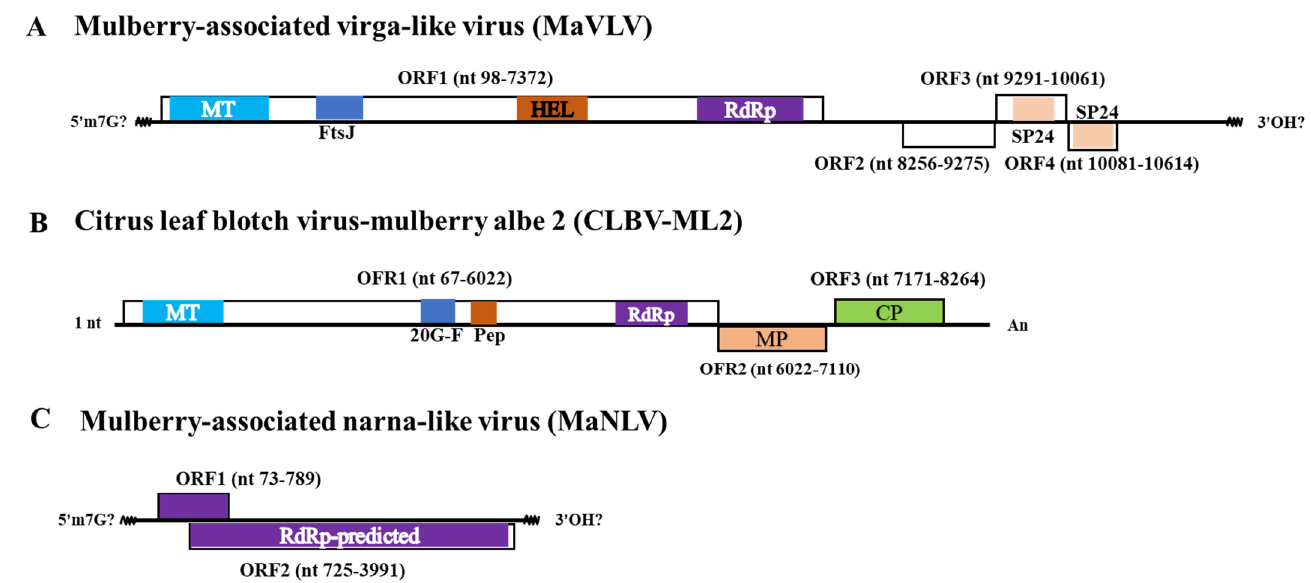
Figure 2. Predicted open reading frames (ORFs, with boxes), conserved motifs, domains, and viral proteins (different colors). ( A ) MaVLV, ( B ) CLBV-ML2, and ( C ) MaNTL. Viral methyltransferase (MT, pfam01660), viral helicase (HEL, pfam01443), and RNA-dependent RNA polymerase_2 (RdRp, pfam00978), 2OG-FeII Oxy superfamily (2OG-F, cl21496), peptidase C23 superfamily (Pep, cl05111), SP24 (pfam16504), coat protein (CP) and movement protein (MP). The unknown sequences of 5 ′ and 3 ′ UTRs are shown by black lines at both extremities, An: poly A tail.